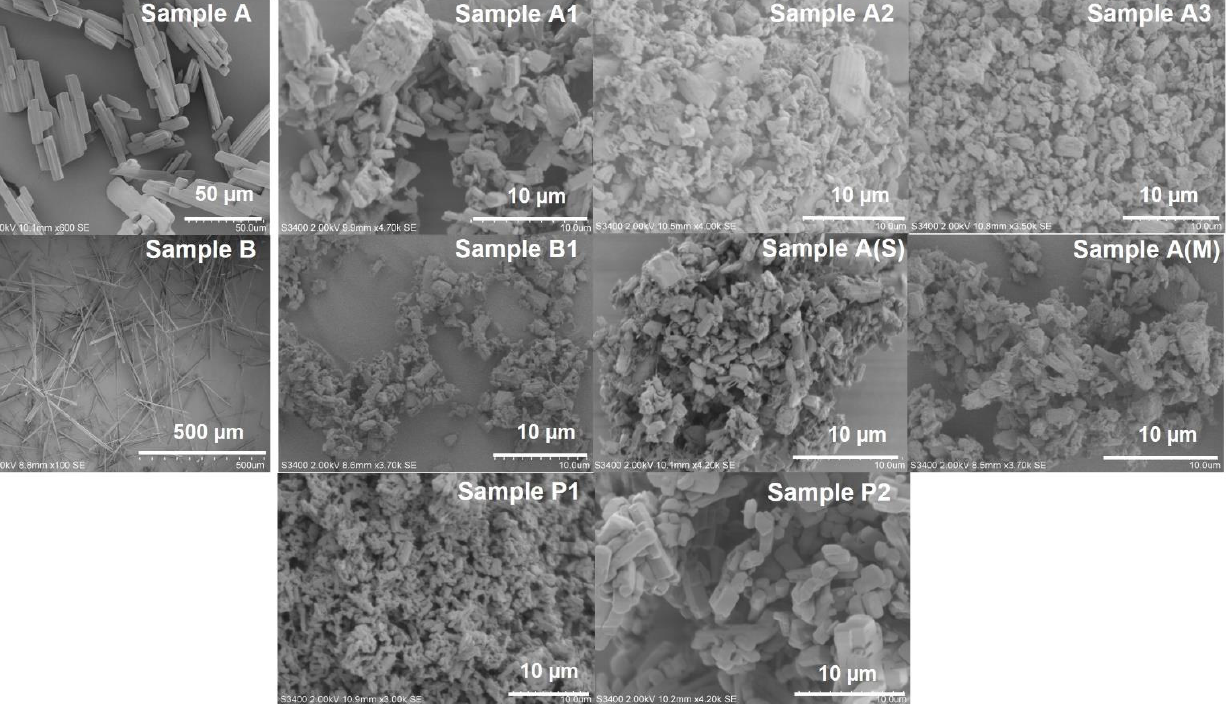
Figure 1. SEM images of crystal morphologies of all Odanacatib samples.